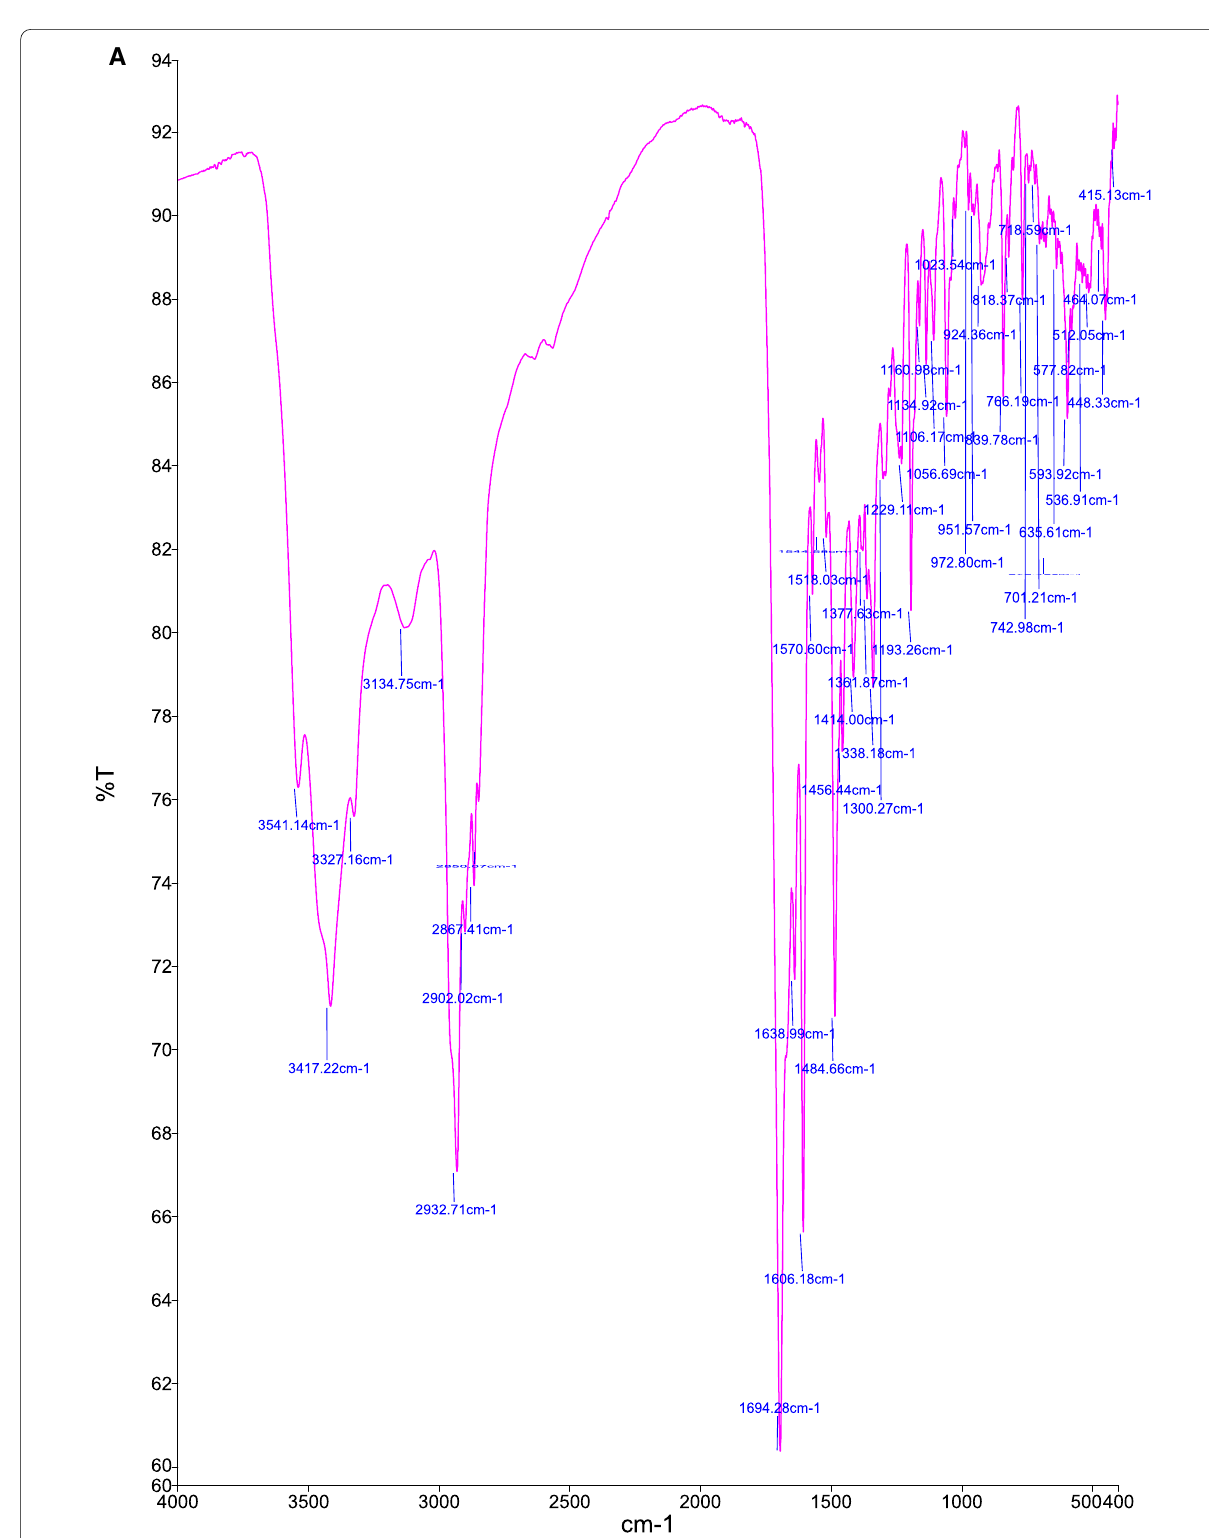
Fig. 2 a FTIR spectrum of Gallic acid (GA), b FTIR spectrum of Polylactic glycolic acid (PLGA), C FTIR spectrum of prepared nanoparticles